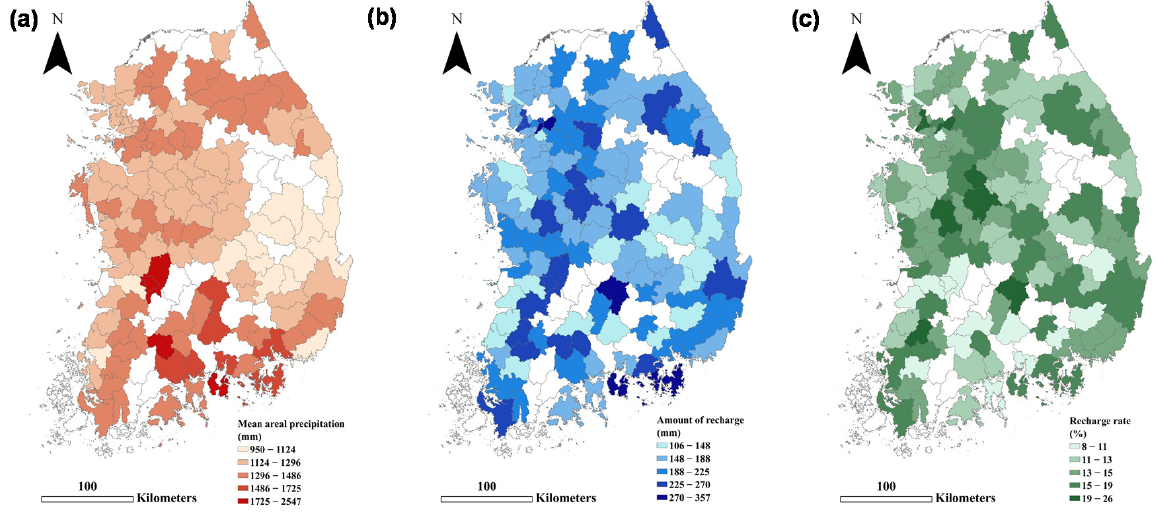
Figure 3. Spatial map of the ( a ) precipitation, ( b ) recharge, and ( c ) recharge rate estimated based on Korean surveys conducted from 1997 to 2020.